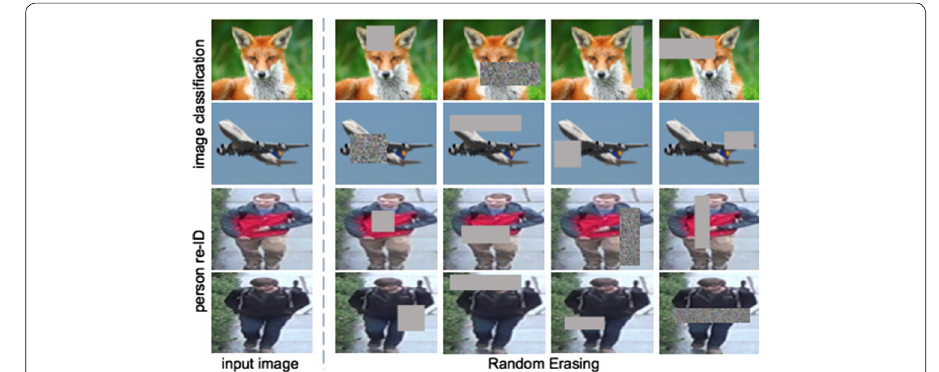
Fig. 11 Example of random erasing on image recognition tasks